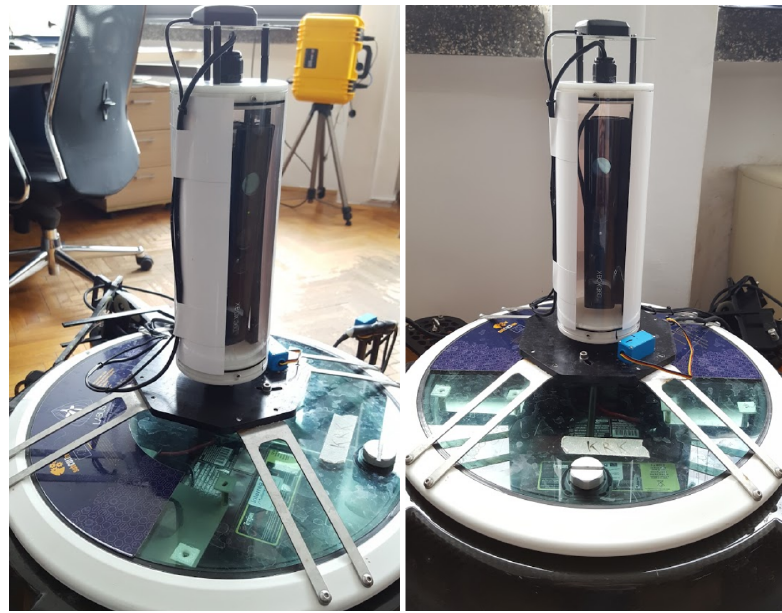
Figure 6. Final setup of the Microsoft Kinect sensor sideways within a watertight tube, mounted on top of the aPad platform with a motorized pan